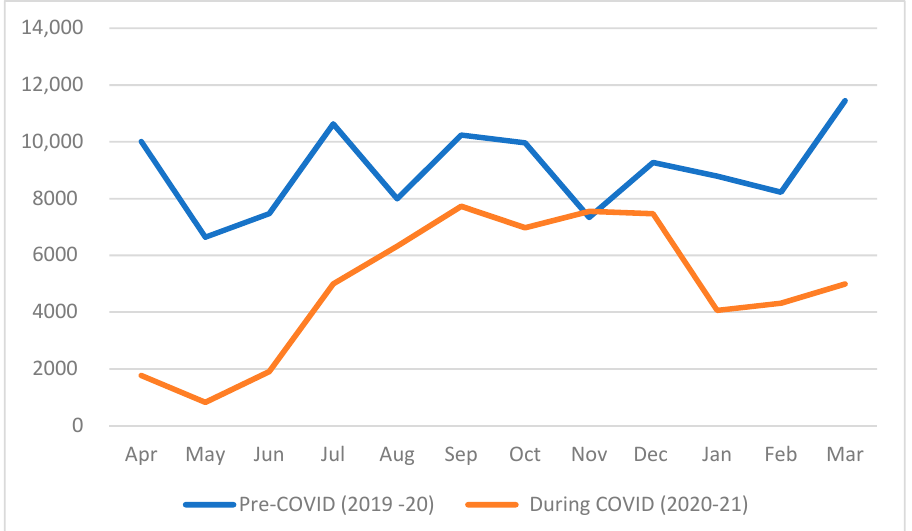
Figure 1. Impact of COVID-19 on overall patient presentation. Table 1. Demographic profile of the population.